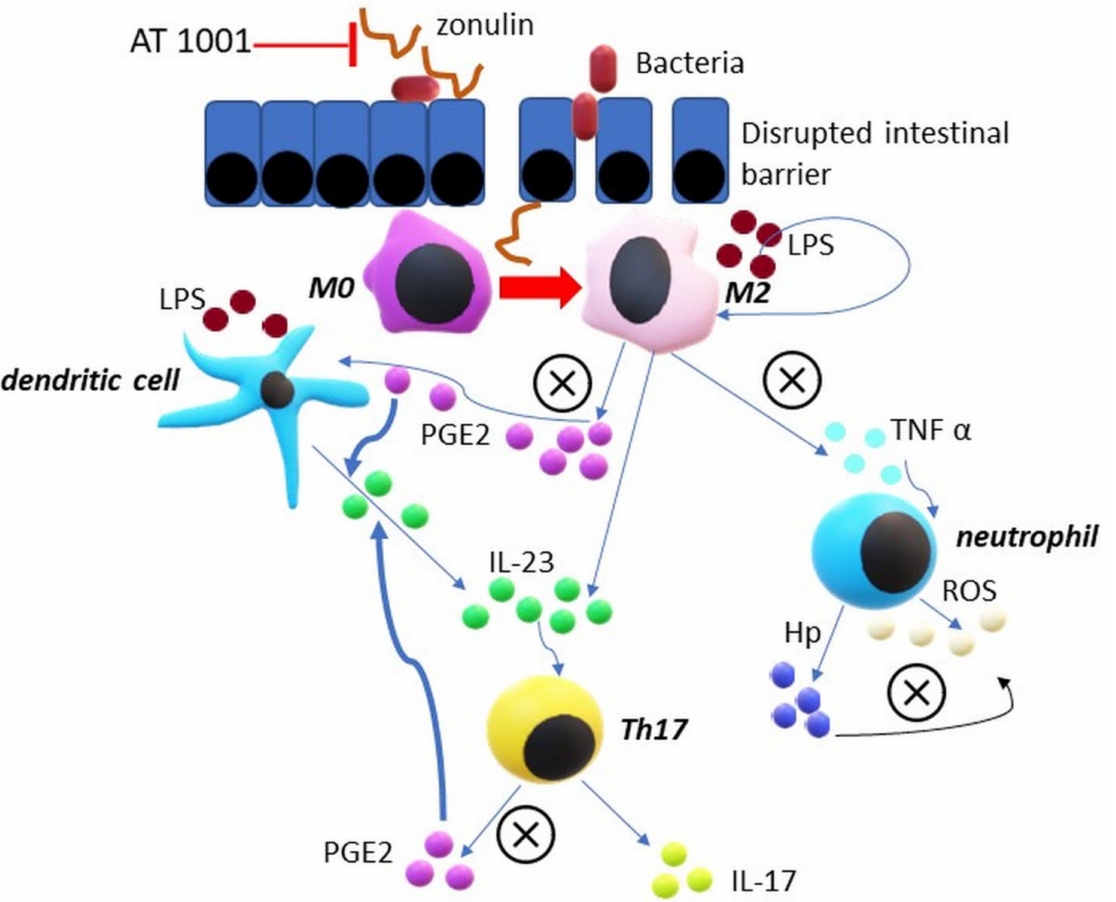
Figure 1. Proposed model of haptoglobin and zonulin impact on pathophysiology of spondyloarthropathies. Enteric bacteria stimulate zonulin secretion. Zonulin increases intestinal permeability and causes bacteria and